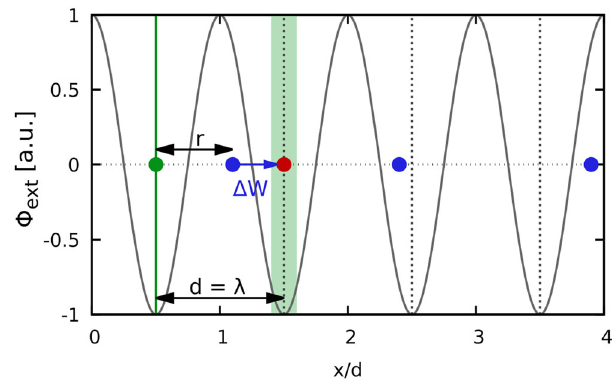
Fig. 2 Illustration of the alignment of electron pairs. Let the green bead be a fi xed reference particle. Without an external perturbation [ ϕ ext , dark grey sinusoidal line], the system is disordered on average in the WDM regime, see the blue beads. In order to follow ϕ ext , the particles have to re-align themselves to the minima of the latter, see blue arrow + red bead. In the process, they change the potential energy of the green reference particle by an amount of Δ W , see Eq. (3). In the regime of electronic pair alignment, λ ~ d , the energy shift Δ W is substantially negative. In other words, a density fl uctuation with a corresponding q = 2 π / λ contains comparably less energy due to its alignment to the potential energy landscape of the system (shaded green area). The random phase approximation (RPA) substantially underestimates this effect and, therefore, does not capture this correlation- induced